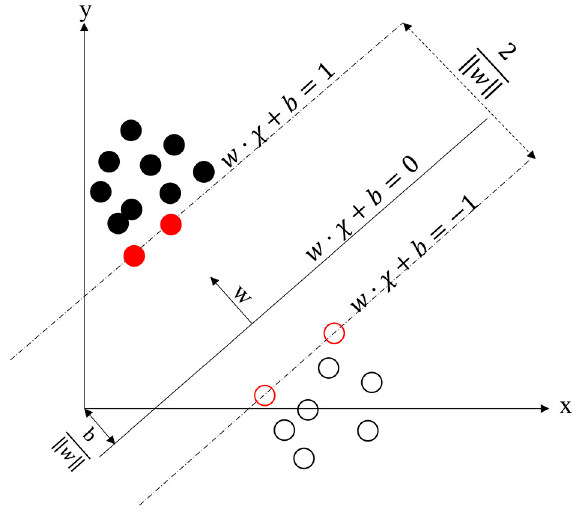
Figure 3. Support vector machine principles.